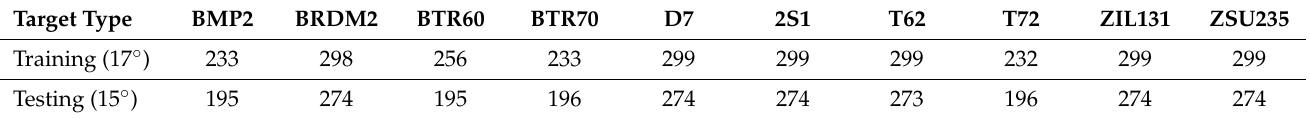
Table 1. Table 1. MSTAR dataset used in experiments.